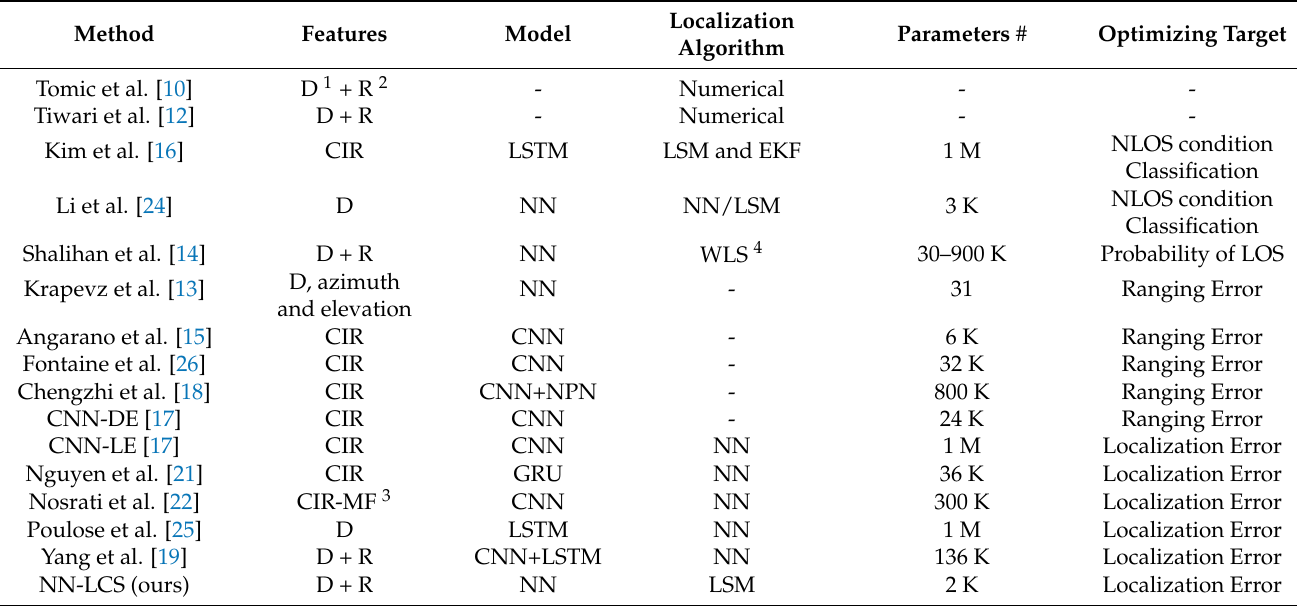
Table 1. Comparison of the related